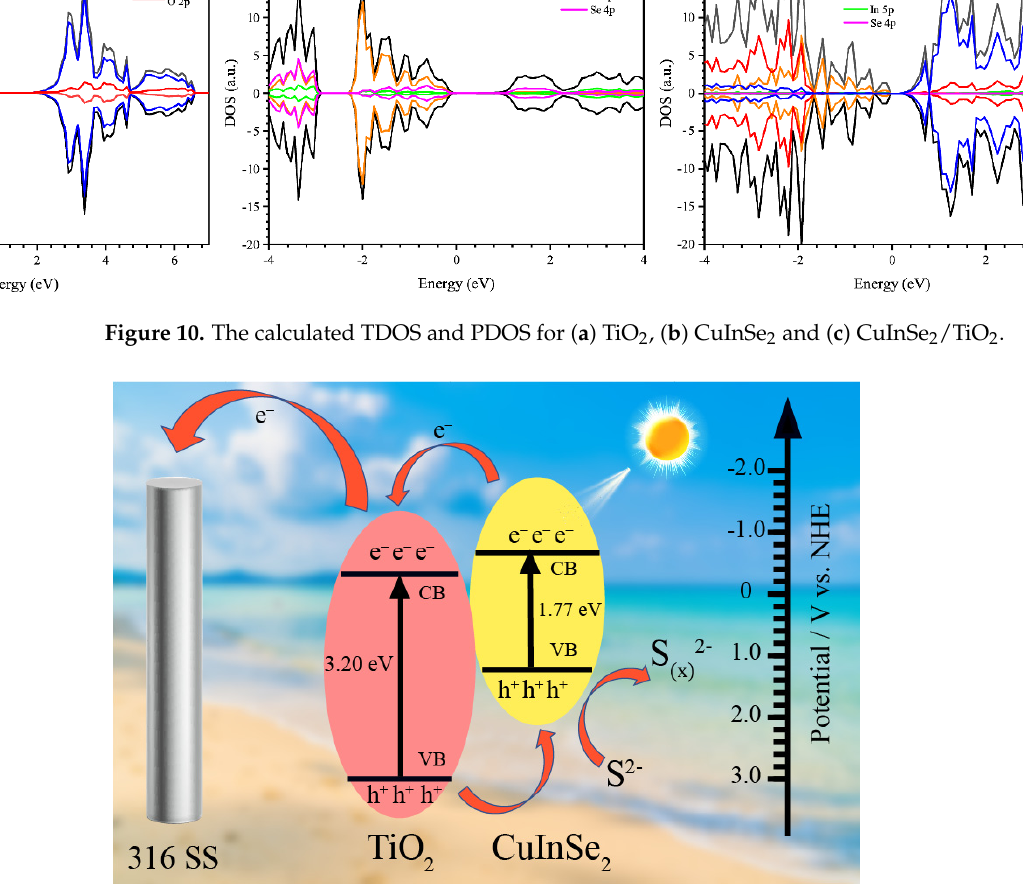
Figure 11. Possible electron ‐ transfer mechanism of the CuInSe 2 /TiO 2 .